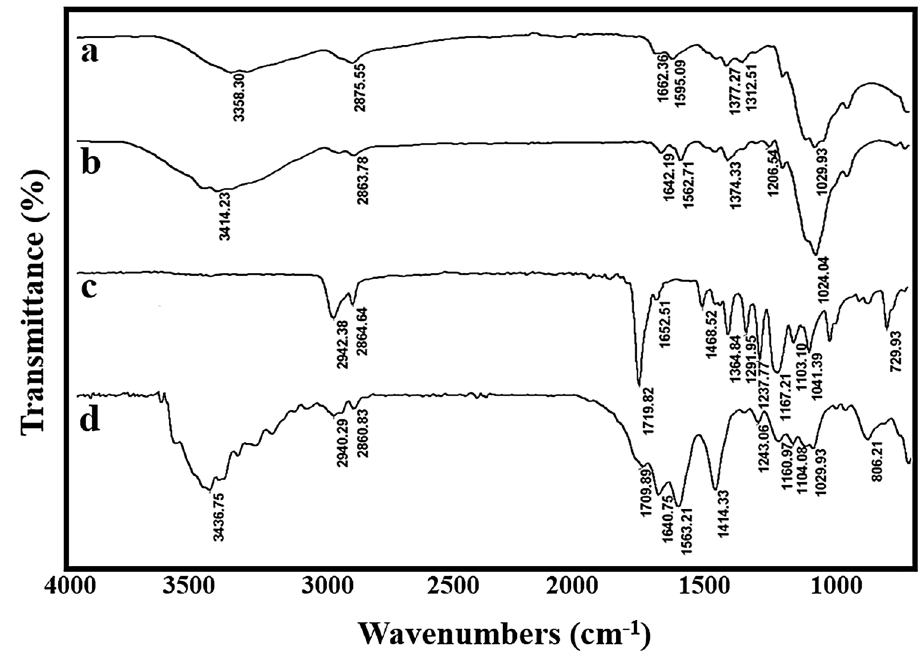
Figure 4. FT-IR spectra of the samples: chitosan ( a ), CSNPs ( b ), PCL ( c ), and CSNPs/PCL 50/25 composite membrane ( d ).